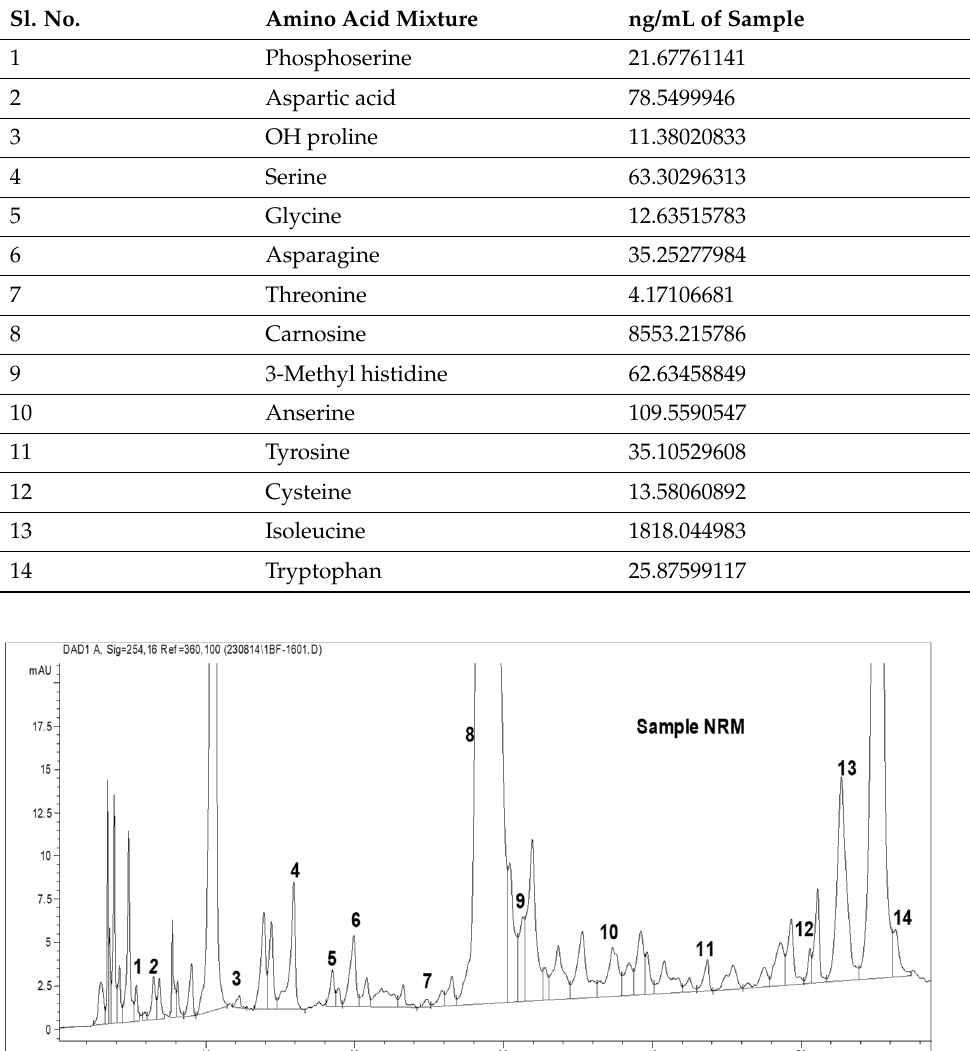
Table 2. TAA content in the R. palustris strain determined by HPLC.